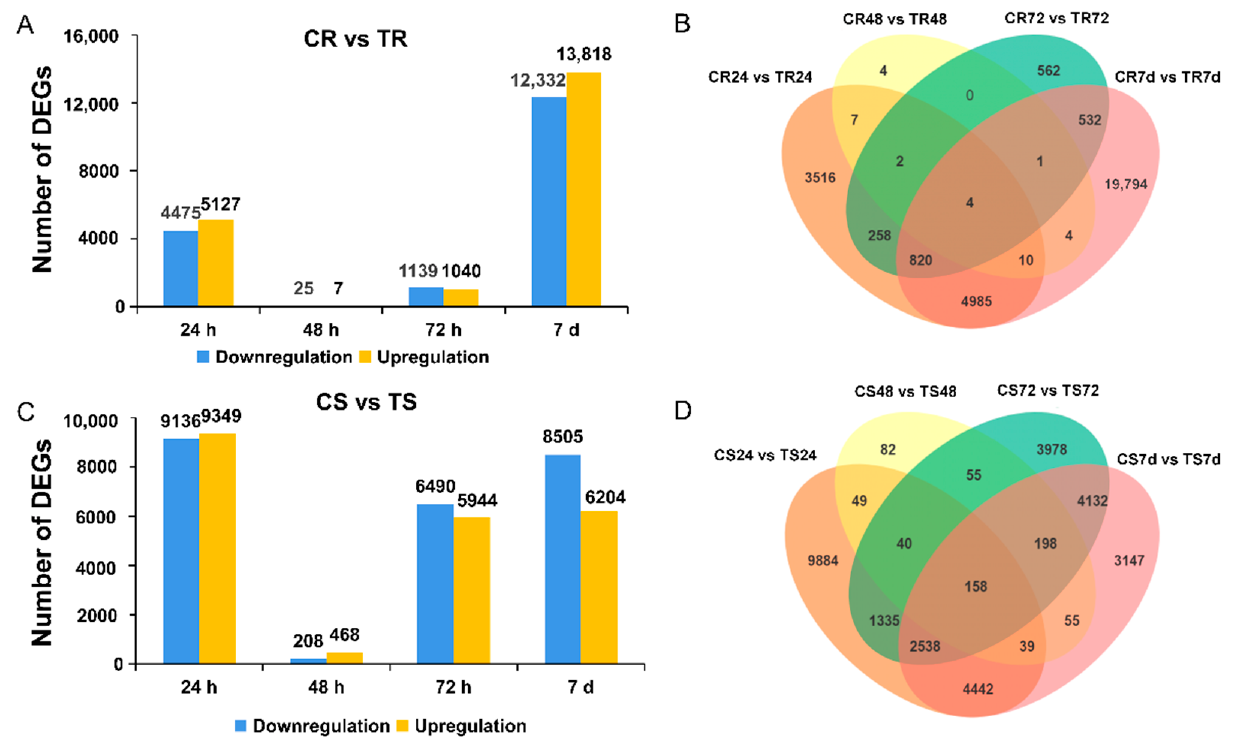
Figure 4. Transcriptional changes in response to F. proliferatum L1 inoculation (|log 2 FC| ≥ 1 and FDR < 0.05). ( A ) The number of DEGs was up- or downregulated at the four time points after inoculation of resistant clonal line. ( B ) Venn plots of the DEGs at the four time points after inoculation of resistant clonal line. ( C ) The number of DEGs was up- or downregulated at the four time points after inoculation of susceptible clonal line. ( D ) Venn plots of DEGs at the four time points after inoculation of susceptible clonal line. DEGs, differentially expressed genes.